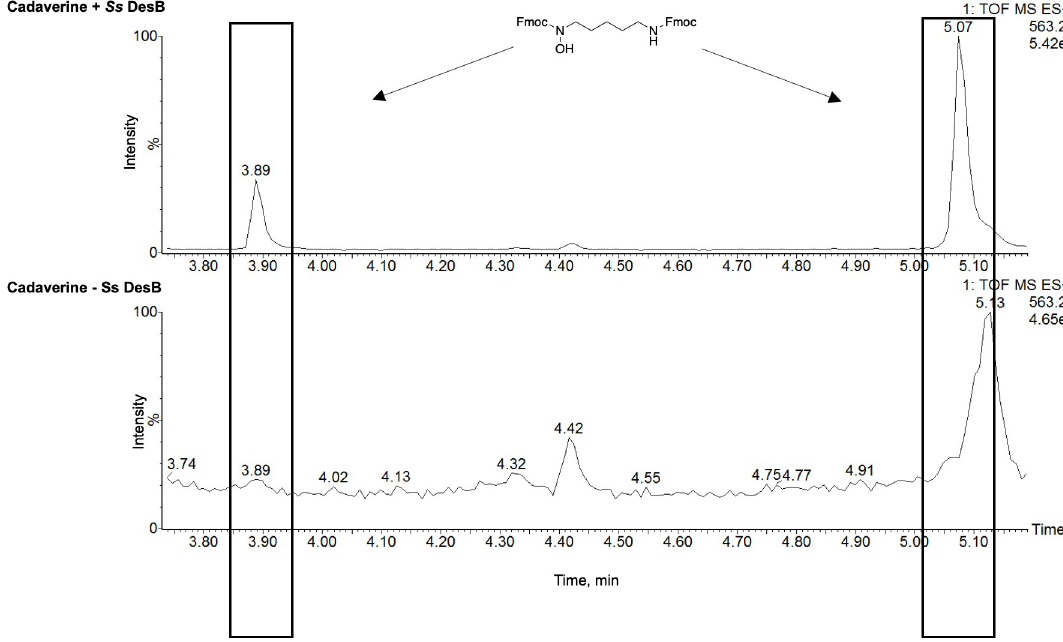
Fig 4. LC/MS detection of N -hydroxycadaverine ( m/z 563.25). LC/MS select ion chromatograms of Fmoc-derivatized N - hydroxycadaverine in assays with and without Ss DesB. Diastereomers are observed.